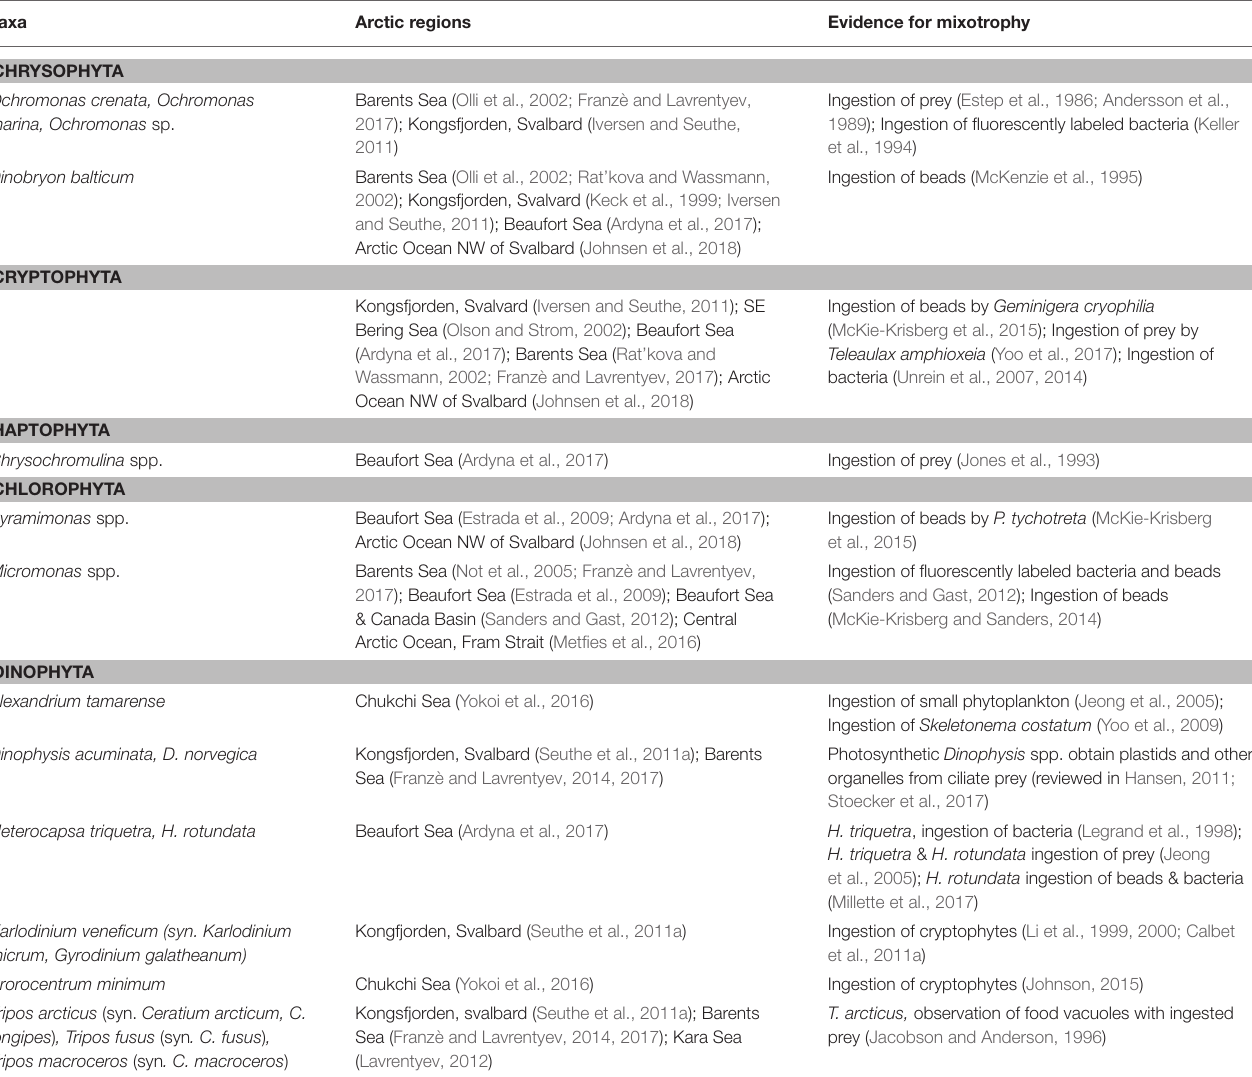
TABLE 1 | Common mixotrophic flagellates in the